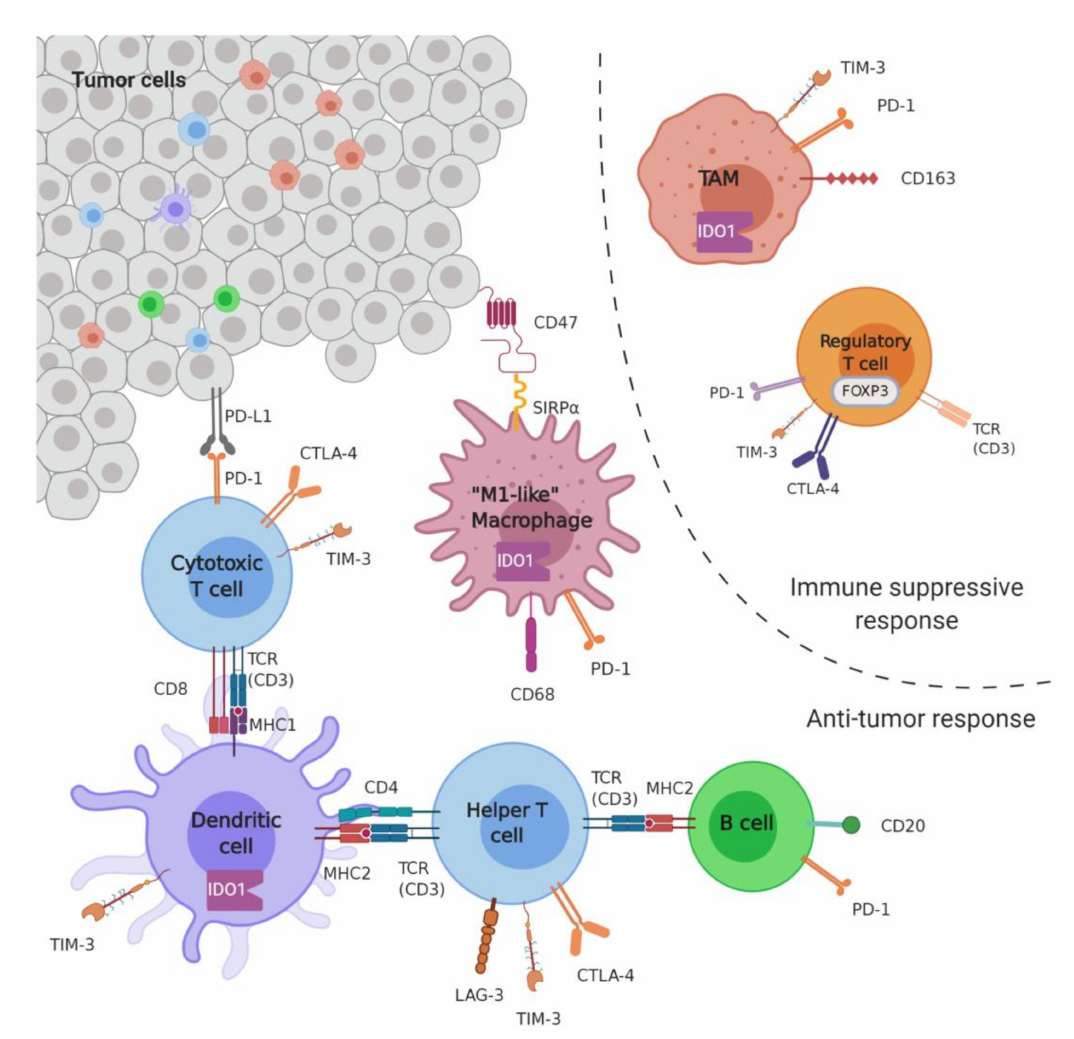
Figure 1. Schematic illustrating the different markers of infiltration and the immune checkpoints reported for different malignancies including STSs. Reprinted with permission from reference [27]. TAM: tumor-associated macrophage. Immune cells in the tumor microenvironment might have immune-suppressive activity or exhibit anti-tumor responses. CD8 + cytotoxic T cells are activated via CD8/ MHC I/ T cell receptor (CD3 or TCR) complexes and helper T cells through the CD4/ MHC II/ TCR complex by dendritic cells. Helper T cells activate CD20 + B cells, inducing plasma cell differentiation and antibody class switching. Macrophages can be pro-inflammatory and anti-tumor CD68 + (M1), or anti-inflammatory and pro-tumor CD163 + (M2) macrophages. FOXP3 + regulatory T cells are immunosuppressive. Immune checkpoints such as PD-1, CTLA-4, TIM-3, and LAG-3 can be found on the surface of a variety of immune cells. The PD-1/PD-L1 axis and CD47/SIRP α axis are two immune checkpoint pathways that interact with tumor